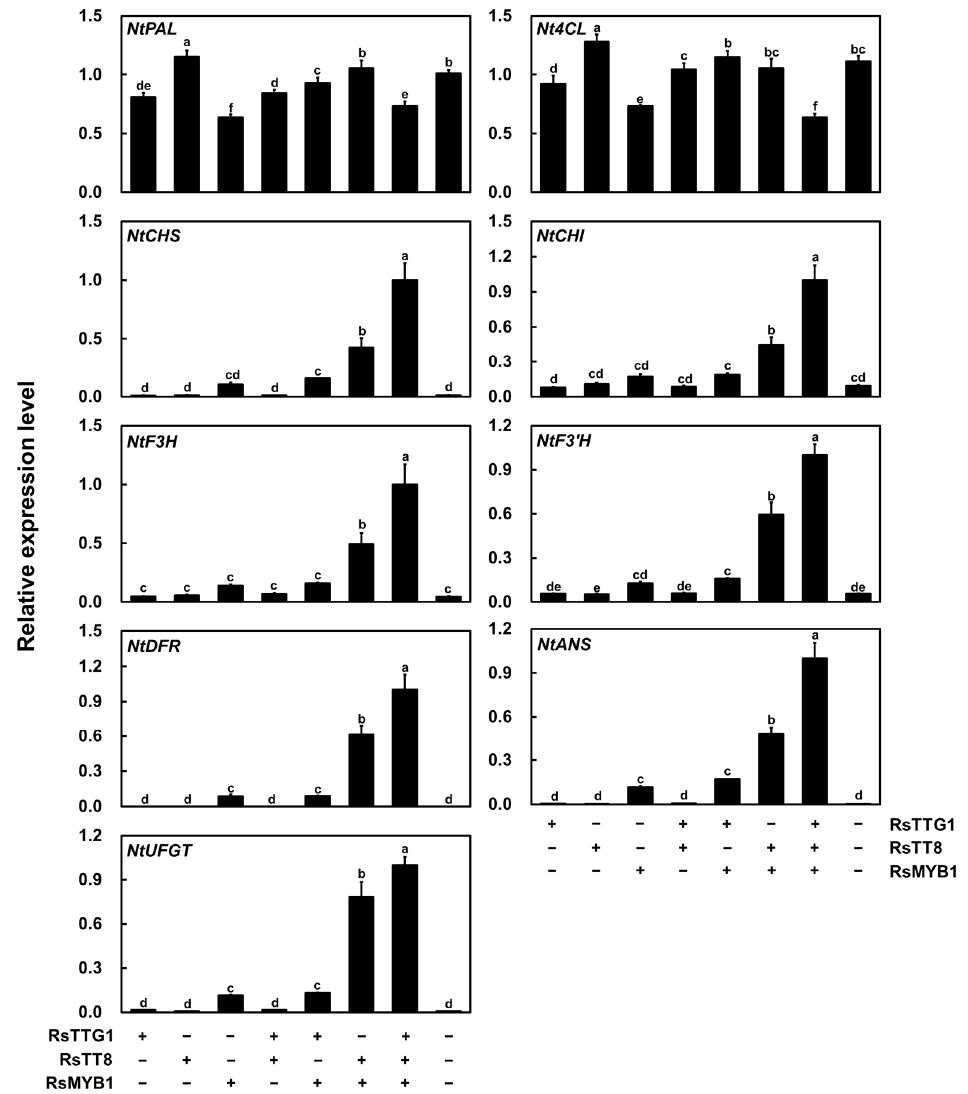
Figure 8. Relative transcription levels of the anthocyanin biosynthesis genes in tobacco leaves transiently expressing various combinations of the RsTTG1 , RsTT8 , and RsMYB1 constructs. These transcription levels were determined using RT-qPCR, with NtGAPDH as the internal reference gene. Results are the means ± SD from three independent biological replicates. Different letters indicate significantly different values ( p < 0.05), as determined using a one-way ANOVA followed by Duncan’s multiple range